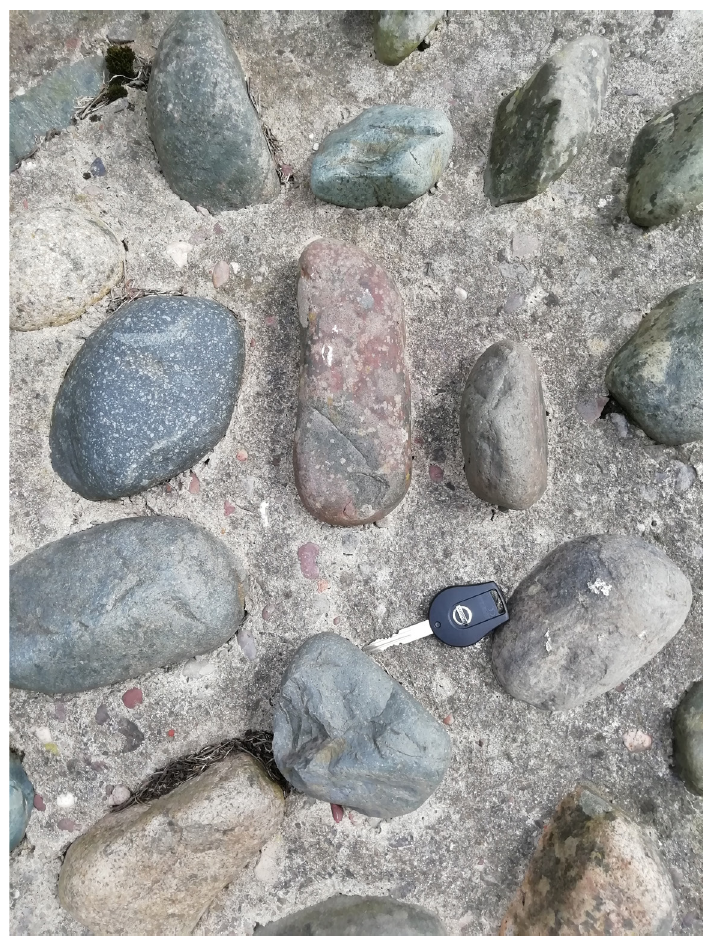
Figure 1. The incorporation of cobbles derived from glacial till into concrete. A common site in post-World War 2 redevelopment